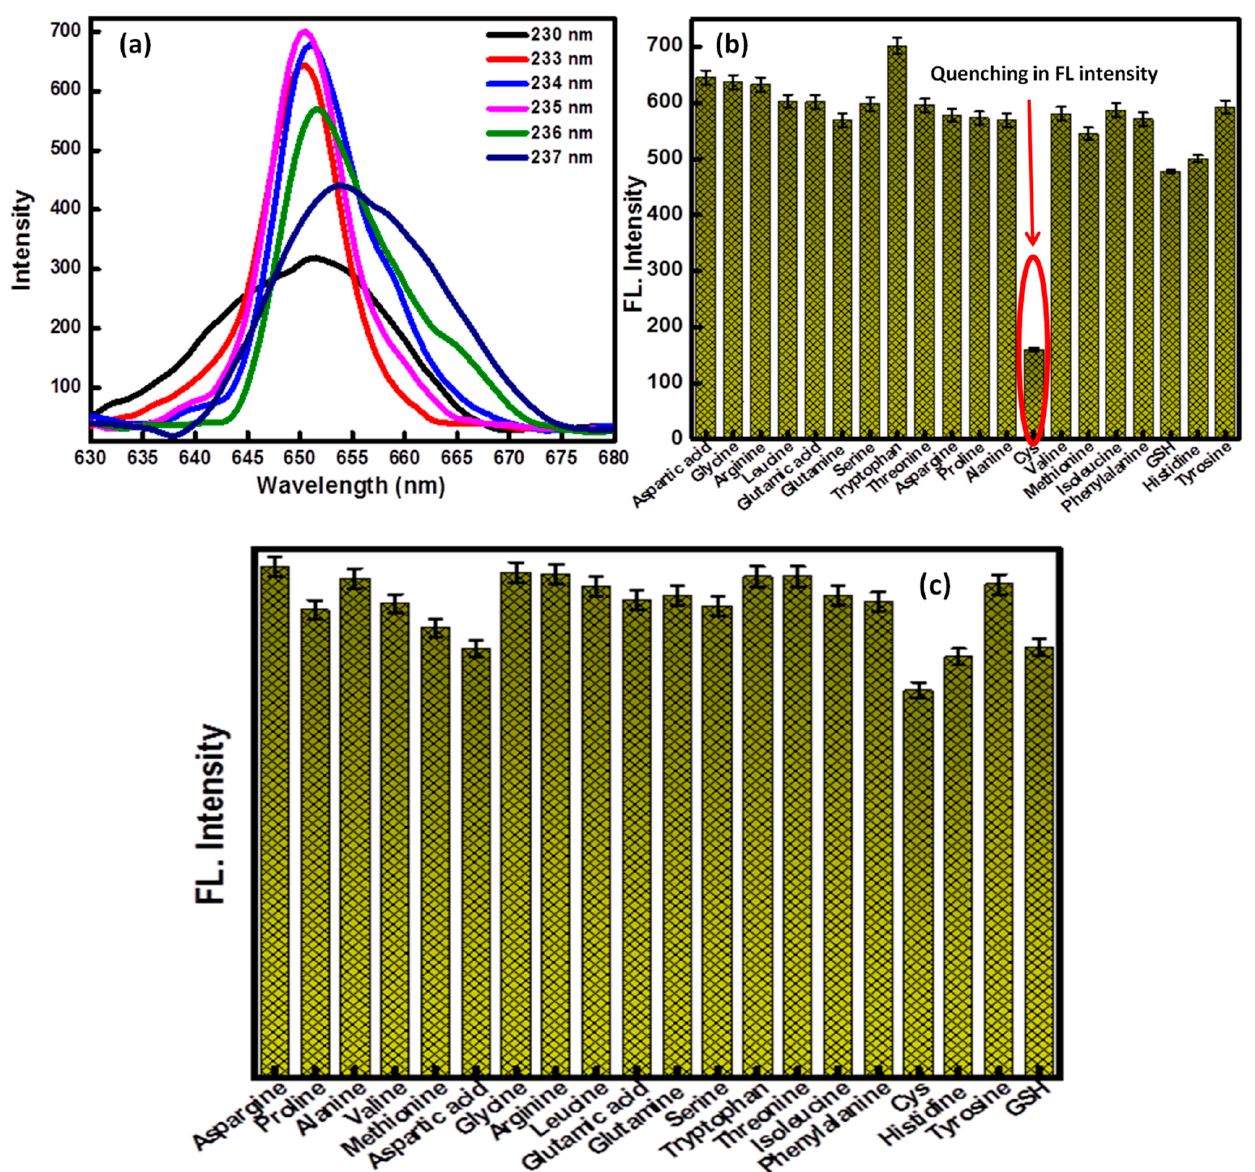
Figure 5. ( a ) The optimization of fluorescence emission intensity of MPTMS@Gd 2 O 3 NPs at various excitation wavelengths. The corresponding changes in the fluorescence intensity of MPTMS@Gd 2 O 3 NPs ( b ) in the presence of various amino acids and ( c ) their selectivity results.